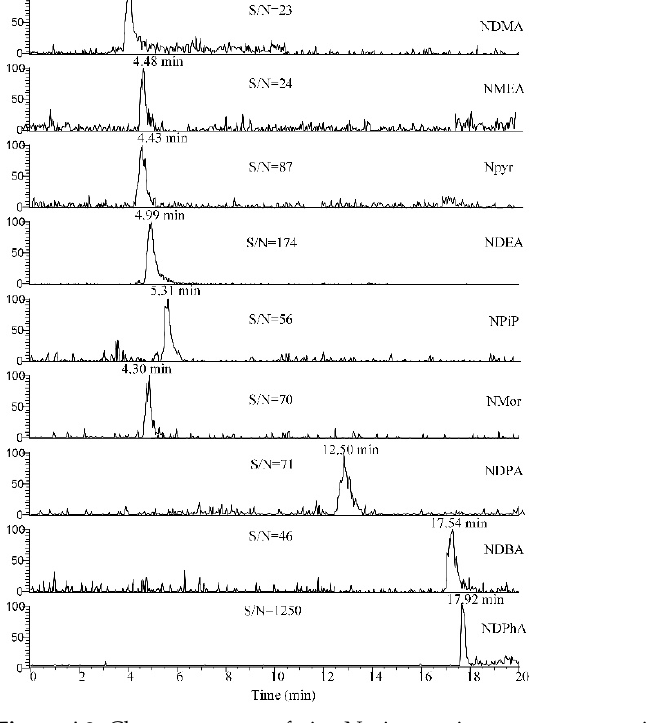
Figure A3. Chromatograms of nine N-nitrosamines at a concentration of 50 ng/L and the corresponding signal-to-noise ratios .